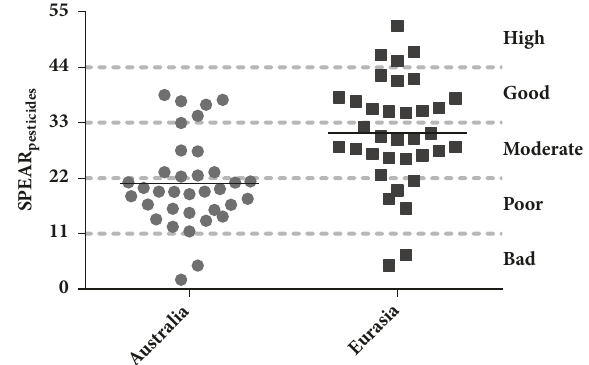
Figure 1: Comparison of the SPEAR pesticides results for the selected sites using the European and Australian databases. The classification categories of Beketov et al. [17] are indicated by dashed